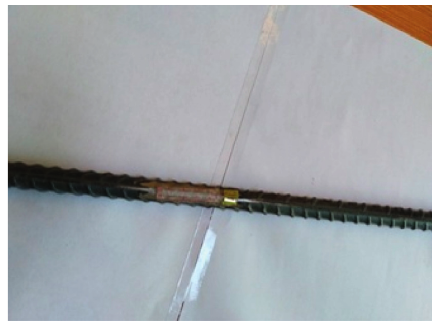
Figure 4: Anchors for test (HRB335, diameter � 12 mm). Figure